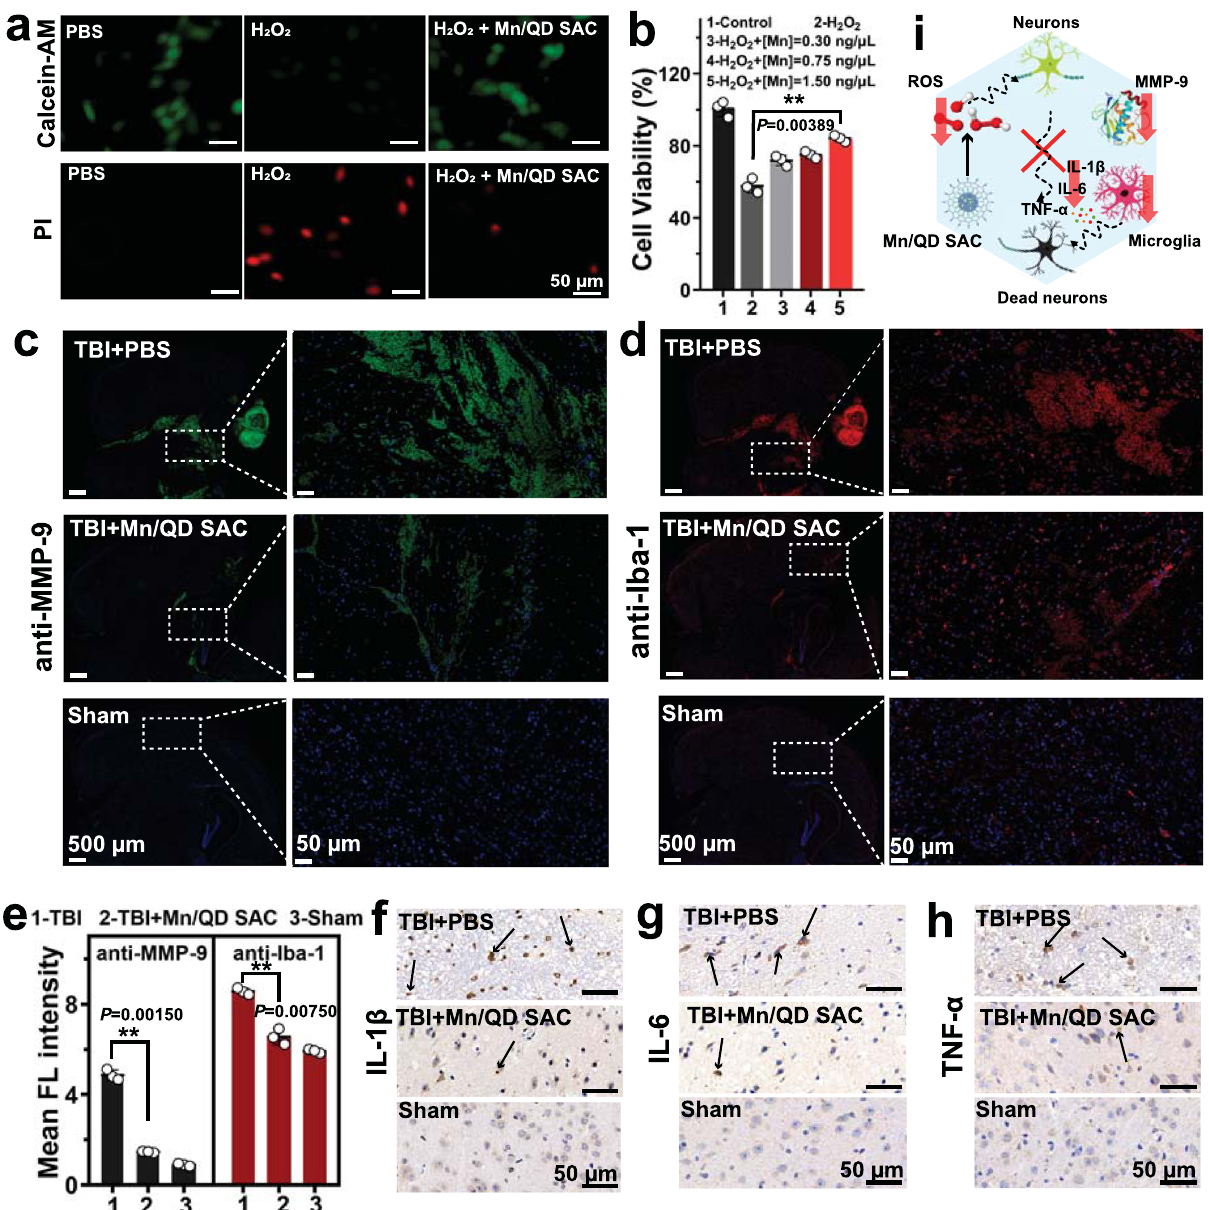
Fig. 5 | Neuroprotective and anti-in fl ammation effects of the Mn/QD SAC for TBI mice. a Representative fl uorescence images of calcein-AM (Green, live cells) and propidium iodide (Red, dead cells) co-stained HT22 cells after different treat- ment. b Cell viability of HT22 cells treated with H 2 O 2 and different concentrations ofMn/QDSACmeasuredbyCCK-8method.Dataarepresentedasmean±SD( n =3 independent samples). c Representative immunostaining images of the brain sec- tions TBI with anti-MMP-9 (Green) for matrix metalloproteinase-9. The immunos- taining images were obtained from the digital slide scanner equipped with 10× objective. d Representativeimmunostainingimagesofthebrainsectionswithanti- Iba-1 (Red) for microglia. The immunostaining images were obtained from the